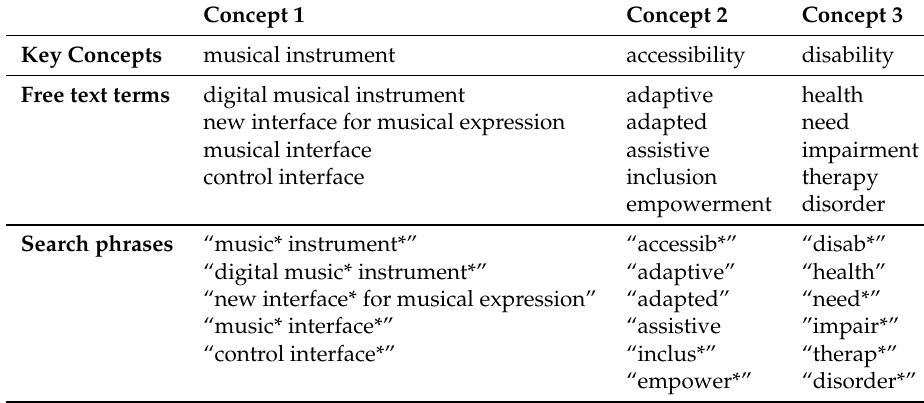
Table 1. Keywords used when searching for publications. Stars* denote wildcards which broaden the search by finding words that begin with the same letters; e.g., “sound*” finds both “sound” and